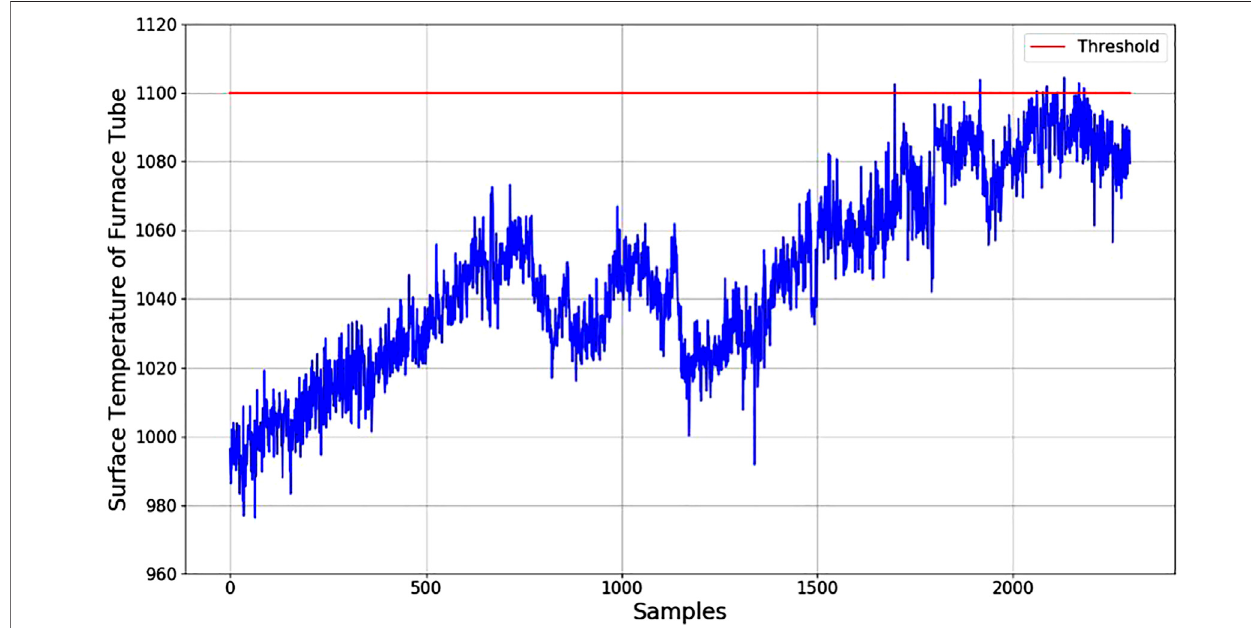
FIGURE 6 | The surface temperature prediction results for the fi rst group of furnace tubes.